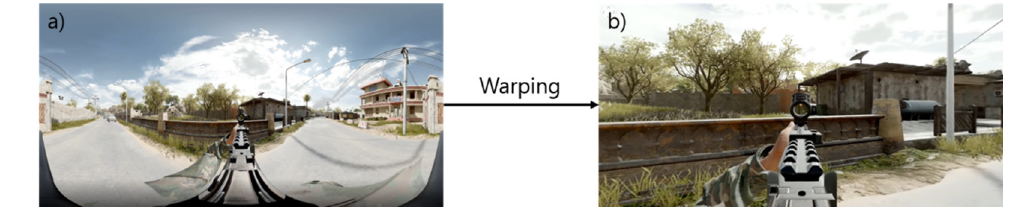
Figure 3. Example of 360-degee video warping. ( a ) 360-degee video. ( b ) Warped video.